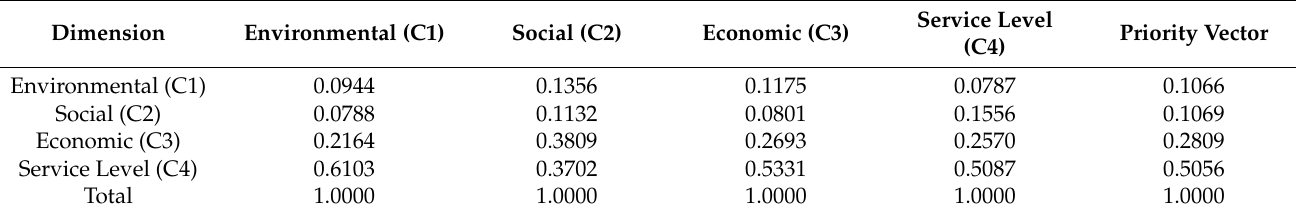
Table 7. The normalized matrix of the